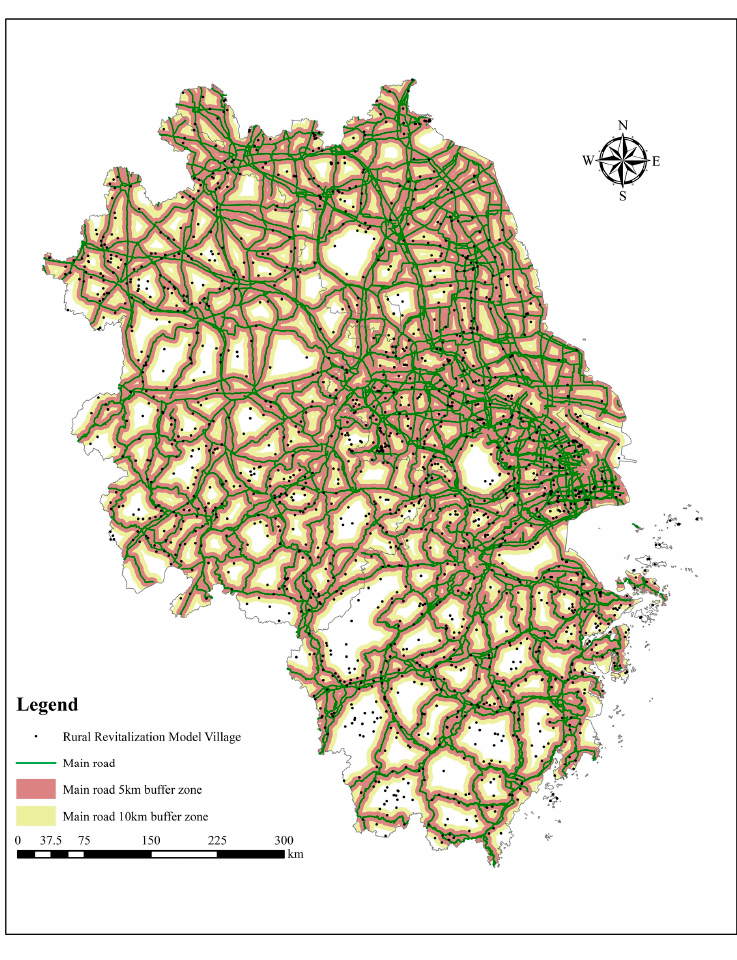
Figure 4. Major roads buffer zone and rural revitalization model villages in the YRD.